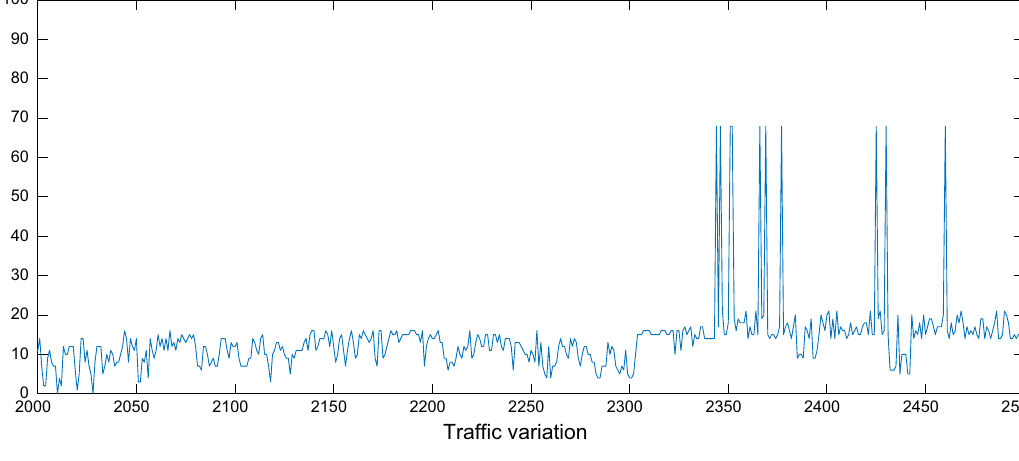
Fig. 5 Variation in travel